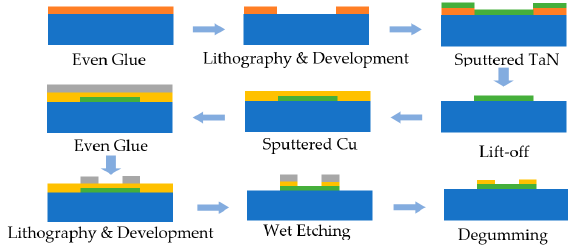
Figure 1. Fabrication of TaN bridge film EC element.